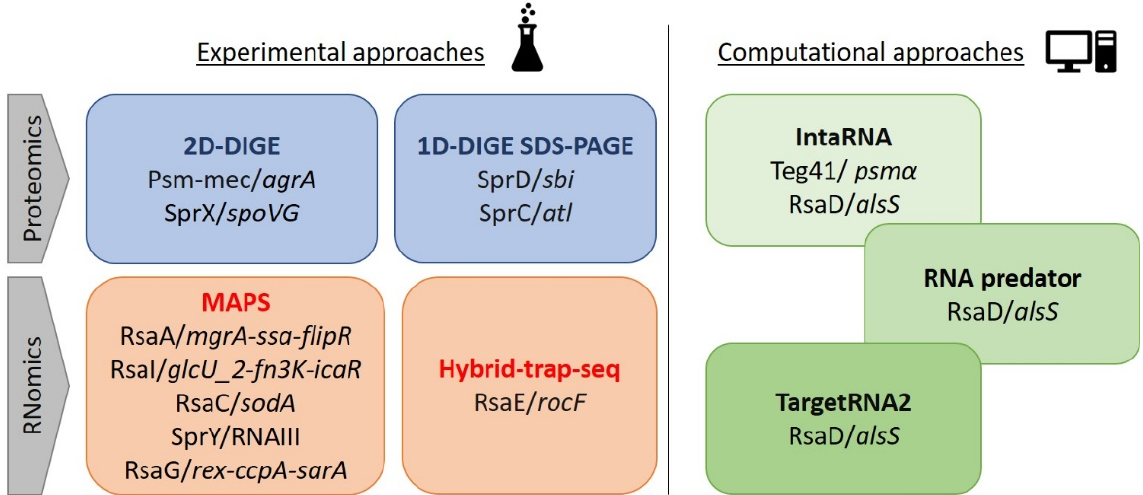
Figure 2. Main experimental and computational approaches used to identify RNA targets of Staphylococcus aureus sRNAs. On the left side are presented experimental approaches based on the identification of RNAs using proteomics or RNomics. On the right side are listed computational approaches. For both methods, examples of sRNAs and their targets are indicated.